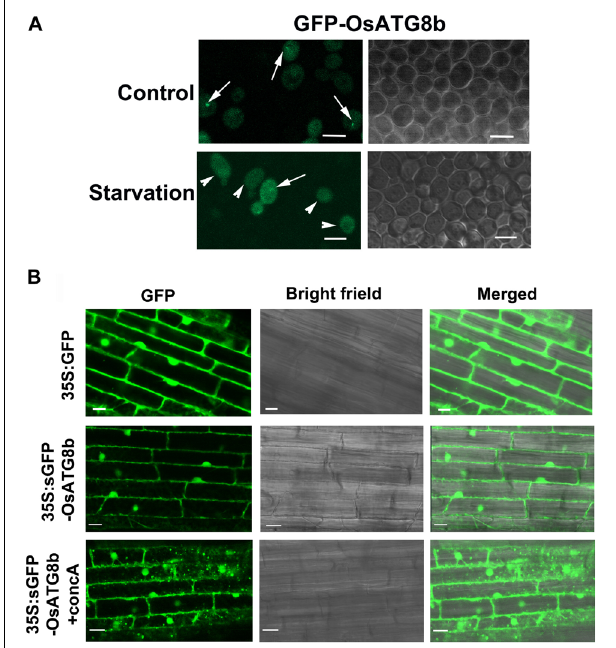
FIGURE 3 | Subcellular localization of OsATG8b. (A) Subcellular localization of GFP-OsATG8b in yeast cells. Yeast cells were grown to mid-exponential phase and then incubated in the presence of 2% galactose to induce GFP-OsATG8b expression. Cells grown in both the control and starvation media were visualized by confocal laser scanning microscope. Arrows indicate the pre-autophagosomal structure (PAS), and arrowheads indicate GFP within vacuoles. Bars = 5 µ m. (B) Subcellular localization of sGFP-OsATG8b in roots of transgenic rice. Fresh root samples of transgenic rice plants expressing 35S:sGFP-OsATG8b were excised and observed immediately (0 h) and after 6-h treatment with 1 µ M concanamycin A. The region at approximately 5 mm from the root tip was observed in a laser scanning confocal microscope. Simultaneously obtained sGFP fluorescence images and DIC images are shown. Bars = 10 µ